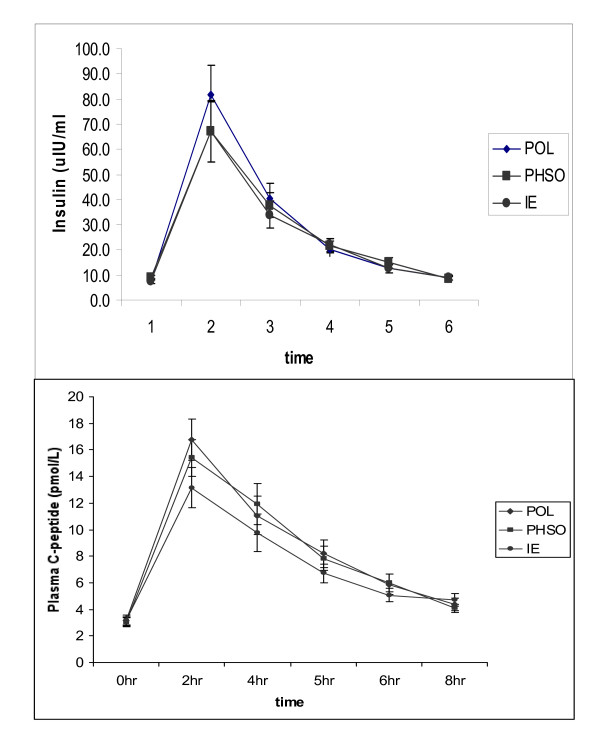
a (top) Postprandial plasma insulin was significantly higher for POL than either other fat after 2 h (mean ± SE). Fig 3b (below) Postprandial plasma C-peptide was significantly lower 2 h after the IE meal (mean ± SE).